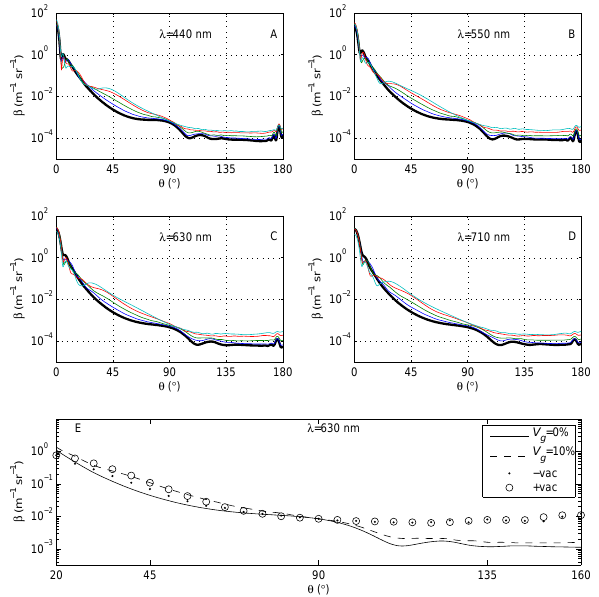
Fig. 5. Volume scattering functions for a population of M. aerugi- nosa at various wavelengths modelled as two-layered spheres with variable gas vacuolation (0–50% cell volume). Legend same as Fig. 2. (E) shows comparison of these results with measurements of vacuolate (+vac) and non-vacuolate ( − vac) M. aeruginosa made by Volten et al. (1998) at 633nm (scaled to San Diego Harbor mea- surements of Petzold (1972) at 90 ◦ ).